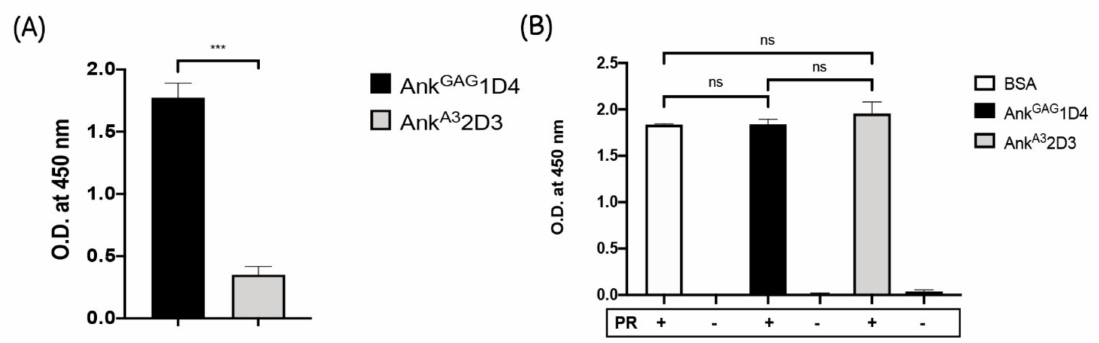
Figure 2. The effect of Ank GAG 1D4 on HIV-1 protease activity. ELISA was performed to determine the effect of ankyrin protein on HIV-1 Gag processing by Protease. ( A ) The H 6 MA-CA-binding activity of artificial ankyrins. Plate was coated with recombinant H 6 MA-CA. Next, Ank GAG 1D4 (Black bar) or Ank A3 2D3 (Gray bar) was added to H 6 MA-CA coated well and incubate for 1 h. The H 6 MA-CA- binding activity was detected by adding rabbit anti-ankyrin polyclonal antibody followed by goat anti-rabbit immunoglobulins-HRP. The data presented in the bar graph was formerly normalised with no ankyrin control. ( B ) The activity of HIV-1 protease was determined using ELISA. Plate was coated with the target of HIV-1 protease (recombinant H 6 MA-CA). Prior to adding HIV-1 protease, the coated plate was incubated with BSA (White bar), Ank GAG 1D4 (Black bar), or Ank A3 2D3 (non- binding ankyrin protein) (Gray bar) for 1 h. The protease activity was determined by the presence of free C terminus of cleaved HIV-MA after cleaving with HIV-1 protease. The detection was measured by adding an anti-MA (HB-8975) monoclonal antibody (binds to the free C terminus of cleaved HIV-MA) followed by a goat anti-mouse immunoglobulins-HRP. The results represent as mean ± SD from a triplicate independent assay. *** p < 0.001; ns, not significant using one-way